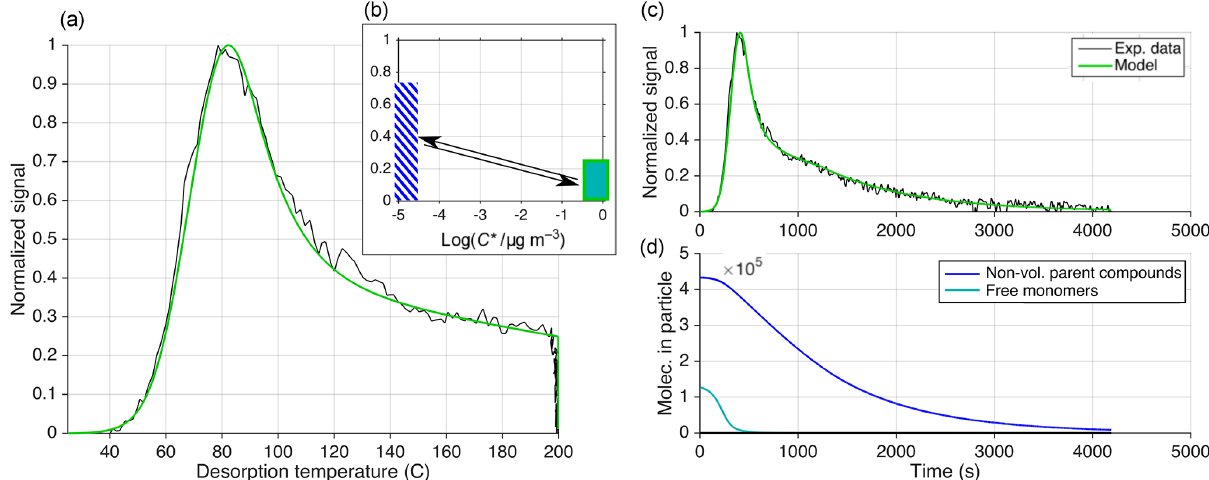
Figure 11. Equivalent to Fig. 9 but presenting the results of using approach 3 (out of three) for reproducing an observed thermogram. Here, reversible oligomerization is included as in Eq. (11), and E d is independent from k d , 0 (Eq. 12). Only one compound is used, with C ∗ 0 . 8µgm − 3 , (cid:49)H = 88kJmol − 1 , and α = 1. Oligomerization parameters are k g , 0 = 1 . 7 × 10 − 3 s − 1 , k d , 0 = 5 × 10 − 4 s − 1 , E g = 0kJmol − 1 , and E d = 6kJmol − 1 . The initial fraction of C 8 H 12 O 5 in the oligomer state is k g , 0 /(k g , 0 + k d , 0 ) = 77%. (d) illustrates how C 8 H 12 O 5 is released from decomposing oligomers during particle desorption (dark blue). In (b) , the low-volatility (presumably oligomer) state is represented by a blue-striped bar at close to 10 − 5 µgm − 3 . However, that is only a rough upper limit, whereas the actual volatility is not known. The arrows illustrate the modeled ongoing reversible oligomerization reactions between monomers (modeled with a volatility of 0.8µgm − 3 ) and practically non-volatile